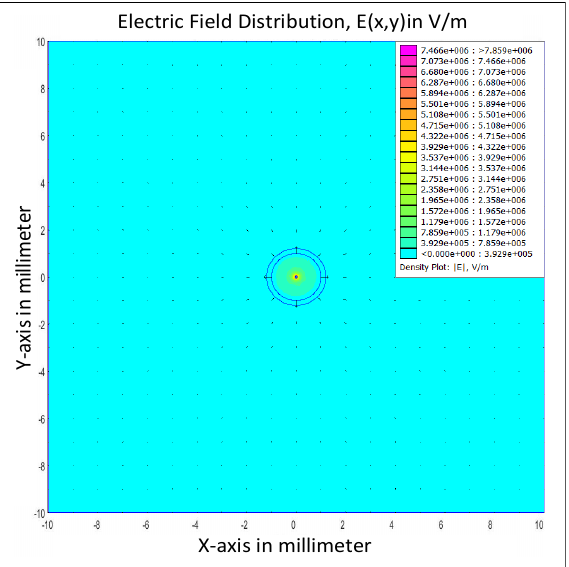
Figure 16. The electric potential distribution of the proposed device when the thickness of metal sheet is doubled.